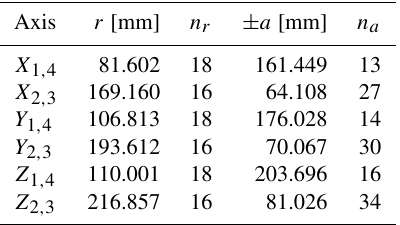
Table 1. Center points of winding packages ( X , Y , Z ), radius r , and distance a to the field center at (0,0,0), as well as number of layers n r and windings per layer n a